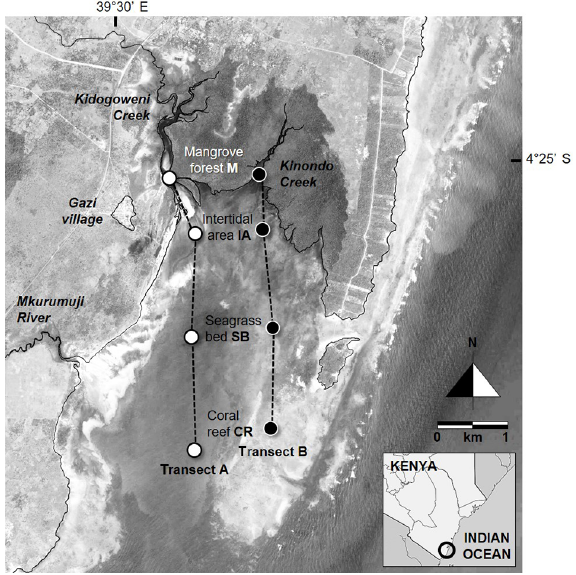
Figure 1. Gazi Bay. Sampling stations lying along two land-to- sea transects are shown: mangrove forest (M), intertidal area (IA), seagrass bed (SB), and coral reef (CR). Transect A (white circles) corresponds to Kidogoweni Creek; transect B (black circles) corre- sponds to Kinondo